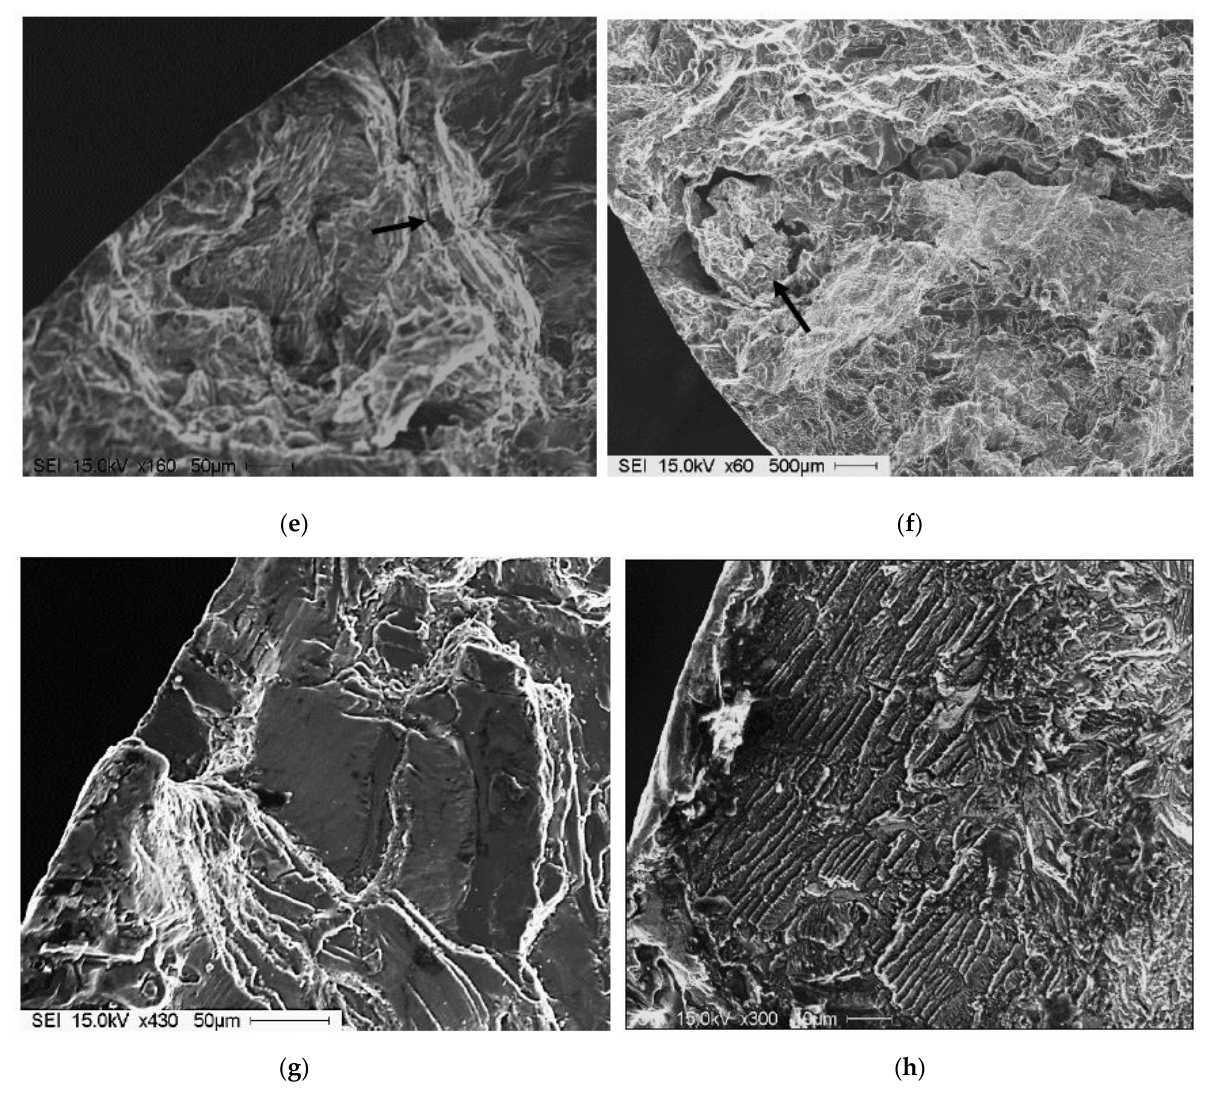
Figure 20. Examples of crack initiation sites: ( a , b ) crack, ( c ) porosity, ( d ) slip bands, ( e , f ) oxide films and inclusions, ( g ) cleavaged areas, and ( h ) river-line striations.